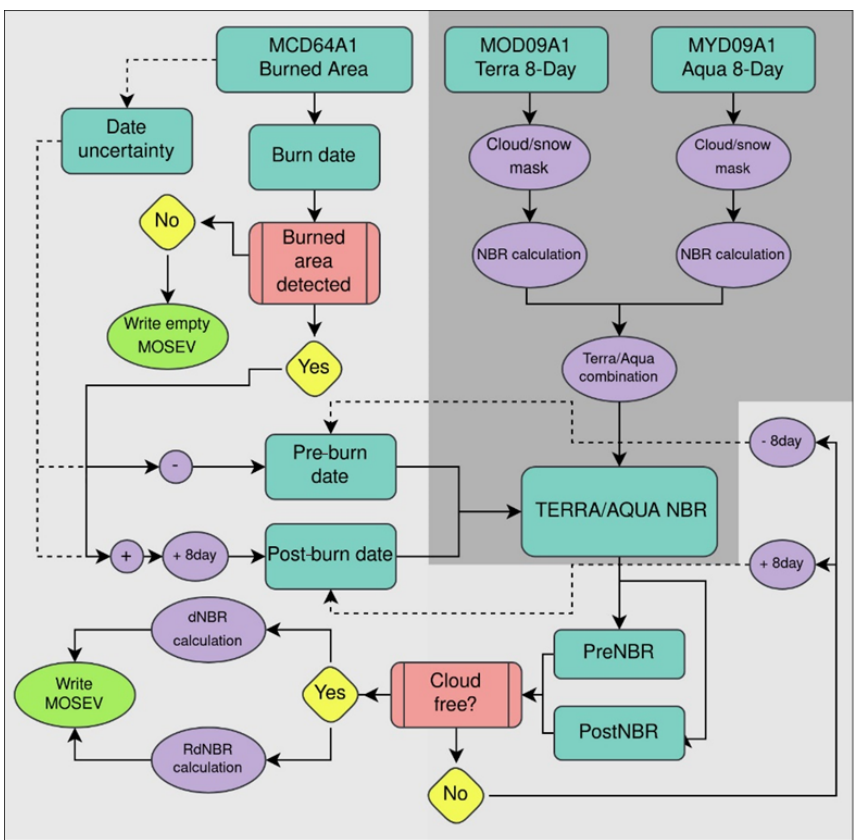
Figure 1. Methodology flow chart used for building the MOSEV database (2000–present). MOD09A1 and MYD09A1 are 8d reflectance products at 500m spatial resolution from MODIS Terra and Aqua respectively. MCD64A1 is the monthly MODIS burned area product at 500m spatial resolution. NBR, dNBR and RdNBR are burn severity spectral indices (normalized burn ratio, difference of the NBR and relativized dNBR